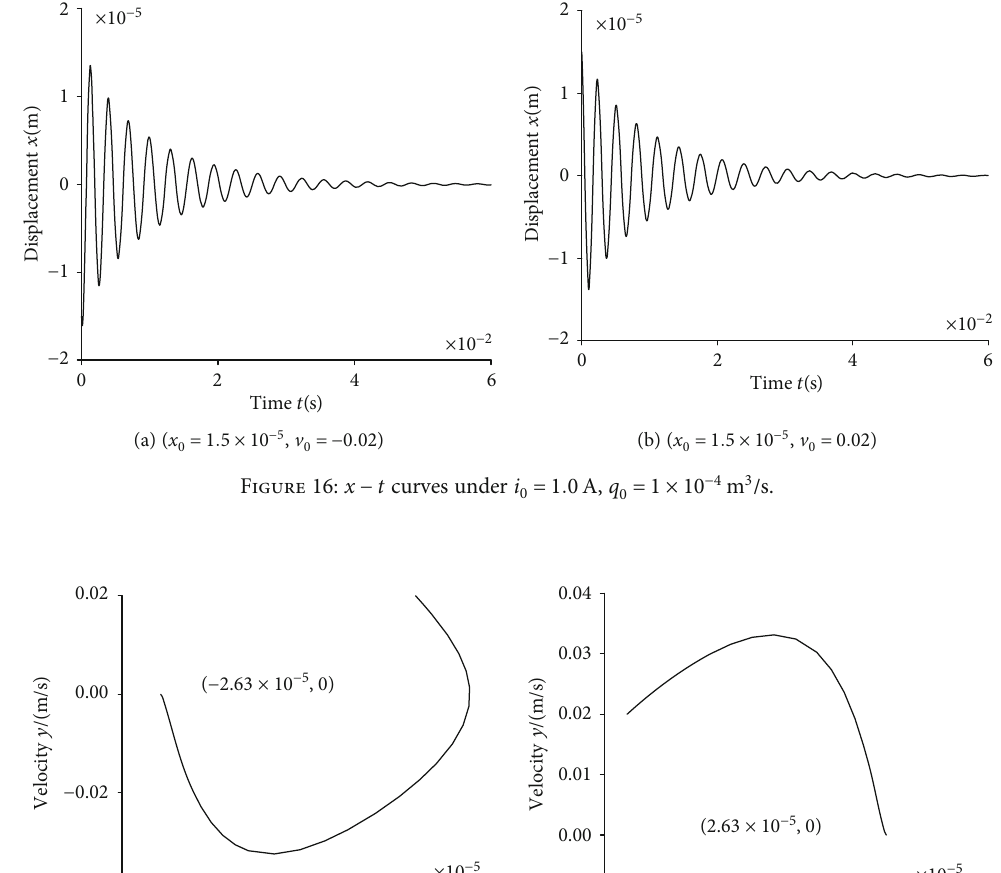
= 1 : 6A , q = 0 : 25 × 10 − 4 m 3 /s . 0 0